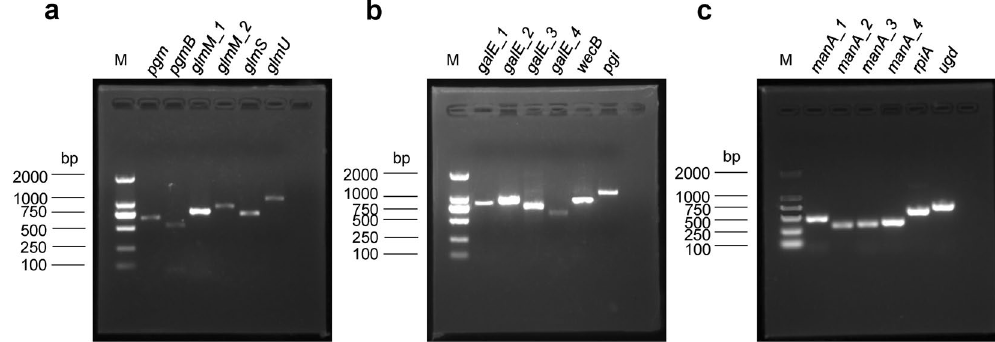
Figure 7. Transcriptional activity of genes involved in polysaccharide synthesis in M. aeruginosa CHAOHU 1326. The reverse transcription PCR products for pgm encoding an alpha-D-glucose phosphate-specific phosphoglucomutase, pgmB encoding a beta-phosphoglucomutase, glmM_1 encoding a phosphoglucosamine mutase, glmM_2 encoding a phosphoglucosamine mutase, glmS encoding a glutamine-fructose-6-phosphate aminotransferase, and glmU encoding bifunctional protein GlmU, are shown in panel a. Amplicons for galE_1 encoding a UDP-glucose 4-epimerase, galE_2 encoding a UDP-glucose 4-epimerase, galE_3 encoding a UDP- glucose 4-epimerase, galE_4 encoding a UDP-glucose 4-epimerase, wecB encoding a UDP-N-acetylglucosamine 2-epimerase, and pgi encoding a glucose-6-phosphate isomerase, are shown in panel b. Amplicons for manA_1 encoding a mannose-6-phosphate isomerase, manA_2 encoding a mannose-6-phosphate isomerase, manA_3 encoding a mannose-6-phosphate isomerase, manA_4 encoding a mannose-6-phosphate isomerase, rpiA